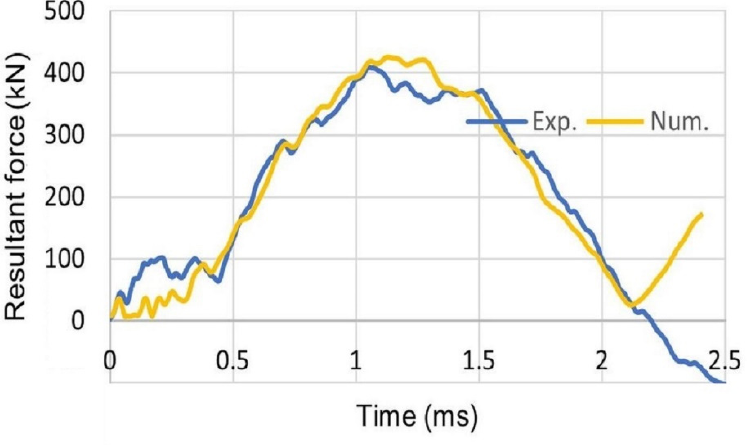
Figure 29. Comparison of the resultant forces obtained from experimental and numerical analyses (shot no. 4).